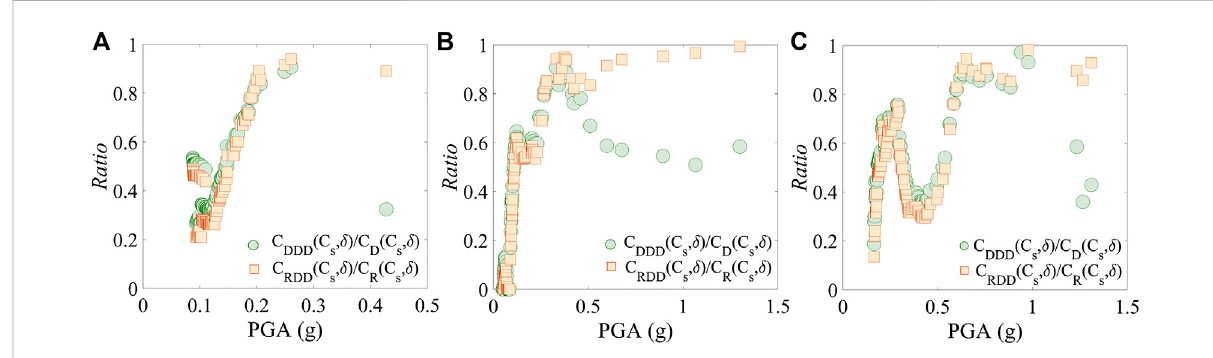
FIGURE 10 Variation of C DDD ( C s | δ ) / C D ( C s | δ ) and C RDD ( C s | δ ) / C R ( C s | δ ) with respect to PGA: (A) RC building located in Mexico City; (B) RC building located in Puebla; and (C) RC building located in the coast of